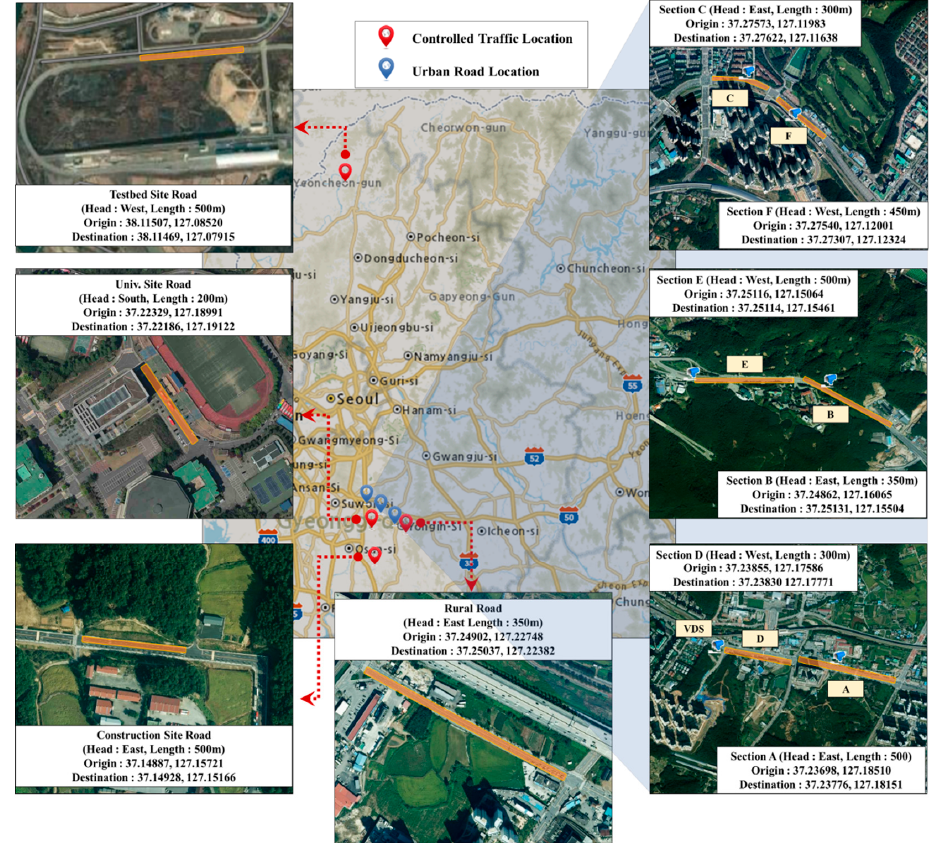
Figure 1. Study area in South Korea (Controlled traffic location and urban road location). Table 1. Road conditions of the measurement section and distance from the observation.